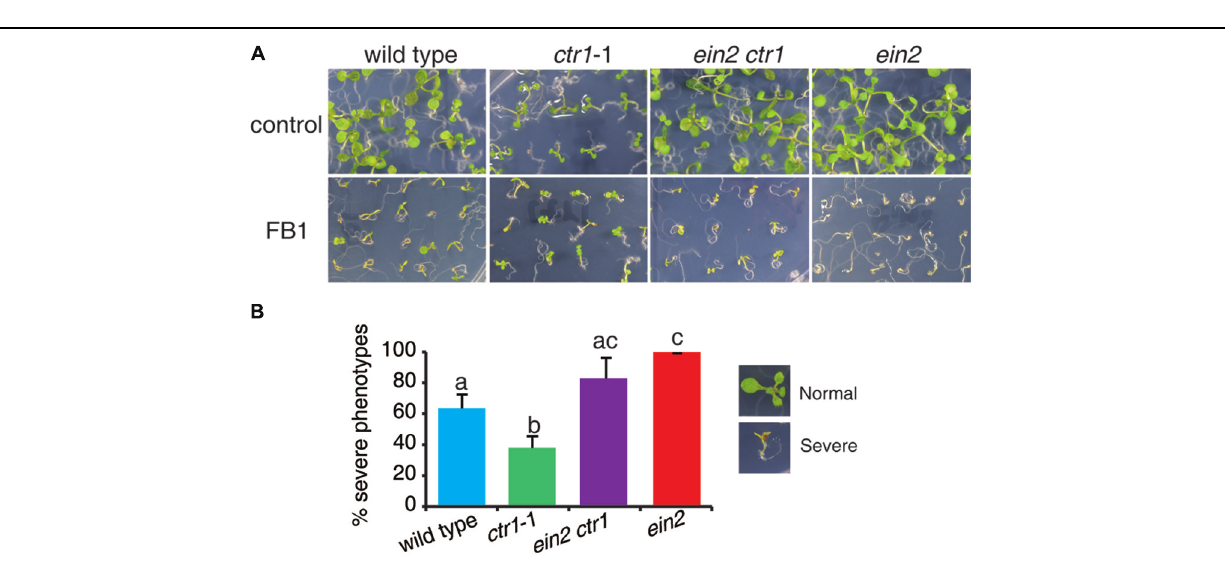
Frontiers in Plant Science | www.frontiersin.org